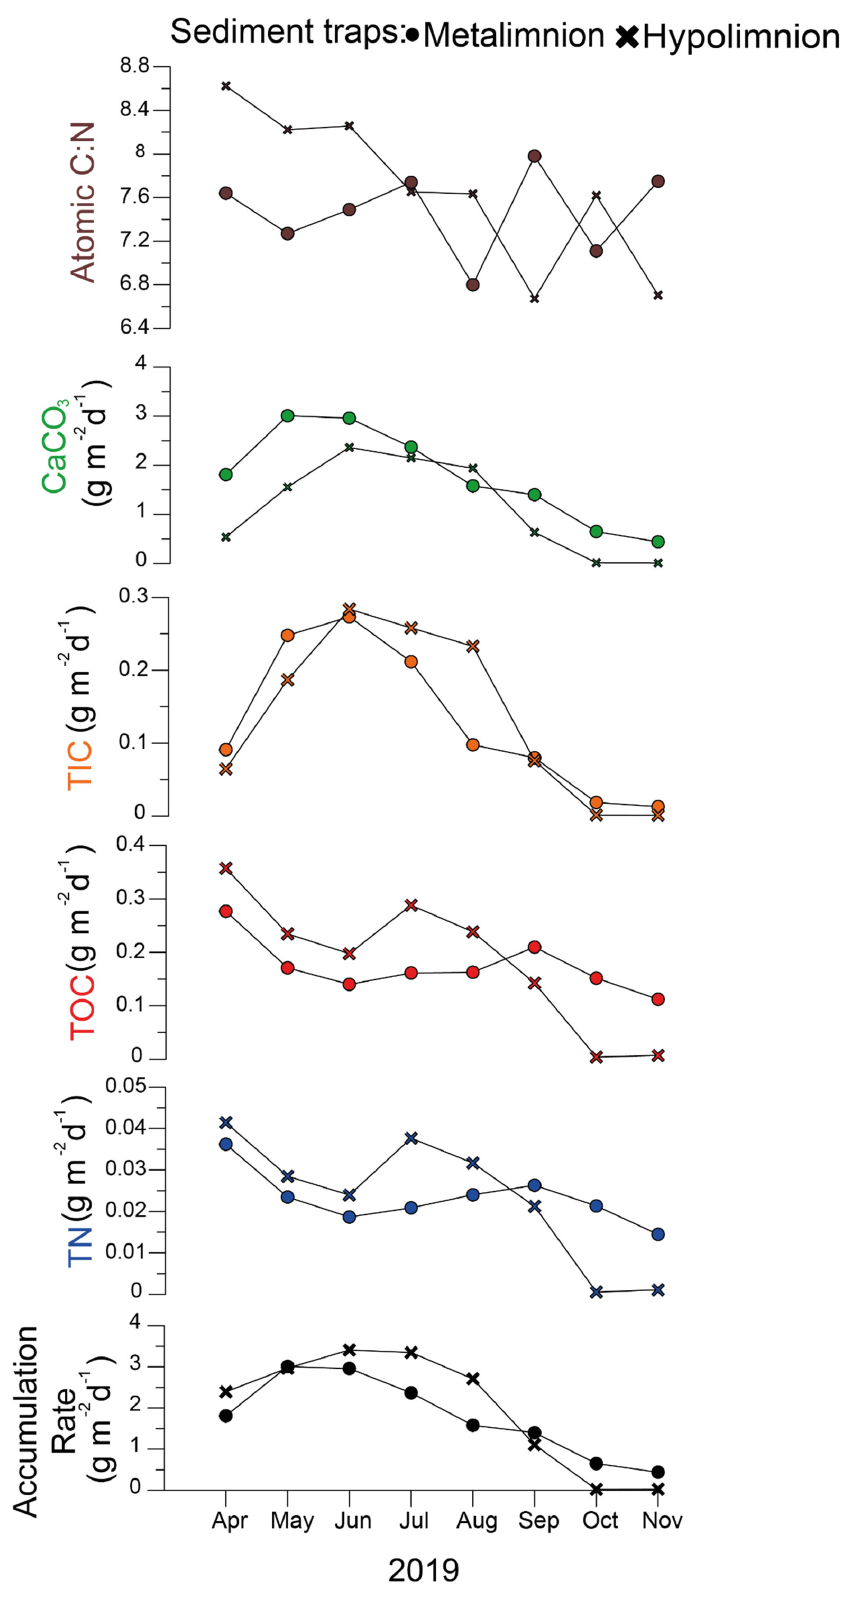
Figure 3. The results of geochemical analysis carried out on sediment trap samples from Lake Tiefer See showing sediment accumulation rate, total nitrogen (TN), total organic carbon (TOC), total inorganic carbon (TIC), calcium carbonate (CaCO3), and atomic TOC and TN ratio (atomic